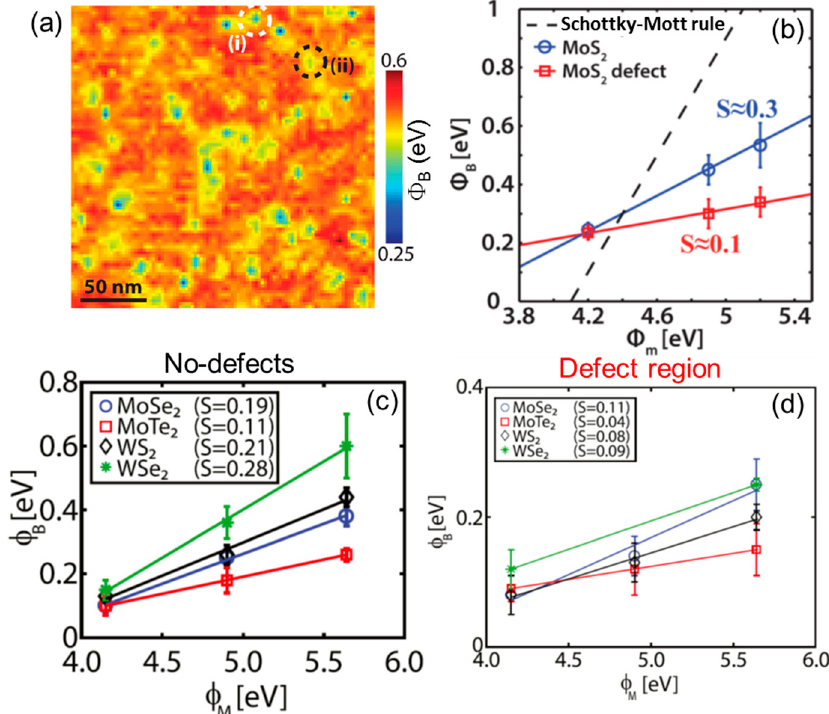
Figure 5. ( a ) Schottky barrier height (SBH) map on the MoS 2 surface obtained by fitting an array of 128 × 128 local current-voltage (I-V) curves with the thermionic emission model. ( b ) SBH for the defect-free MoS 2 areas (blue) and on subsurface defects (red) vs. the metal tip work function ( Φ M ). The pinning factor S was evaluated as the slope of the linear fit. The dotted line is the standard Schottky–Mott rule. The SBH of different TMDs (MoSe 2 , MoTe 2 , WS 2 , WSe 2 ) for defect-free ( c ) and defect regions ( d ) vs. the metal tip work function. Panels ( a ) and ( b ) adapted with permission from Reference [45], copyright from the Chemical Society 2017. Panels ( c ) and ( b ) adapted with permission from Reference [75], copyright from the American Chemical Society 2019.